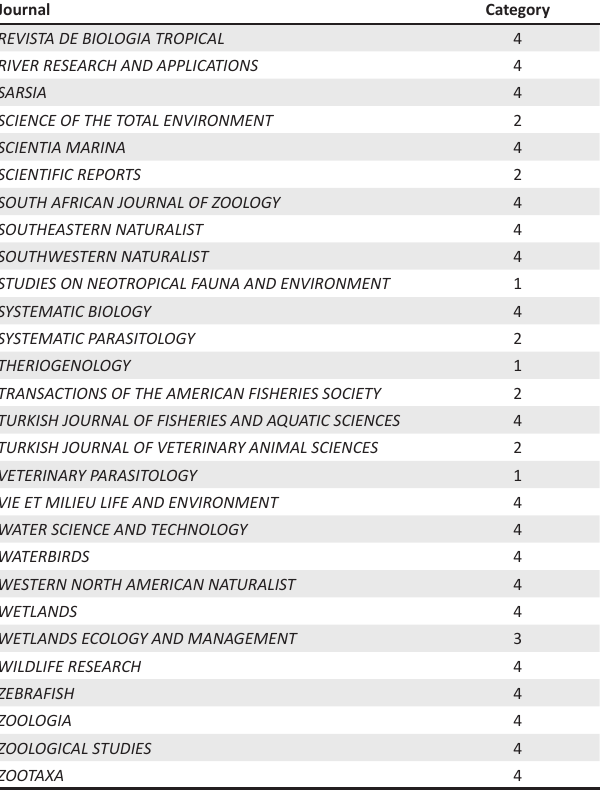
TABLE 1-A1 (Continues…): Categorisation, based on animal ethical requirements, of 250 ISI-rated, peer-reviewed, scientific journals with the most articles relating to fish research, revealed through a Web of Science (Thomson Reuters)